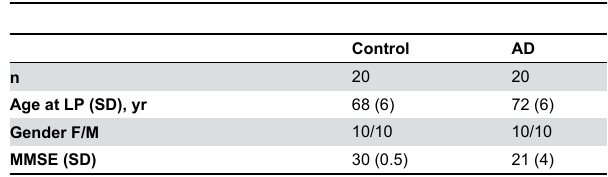
Table 2. Demographics of 20x20 CSF sample set.